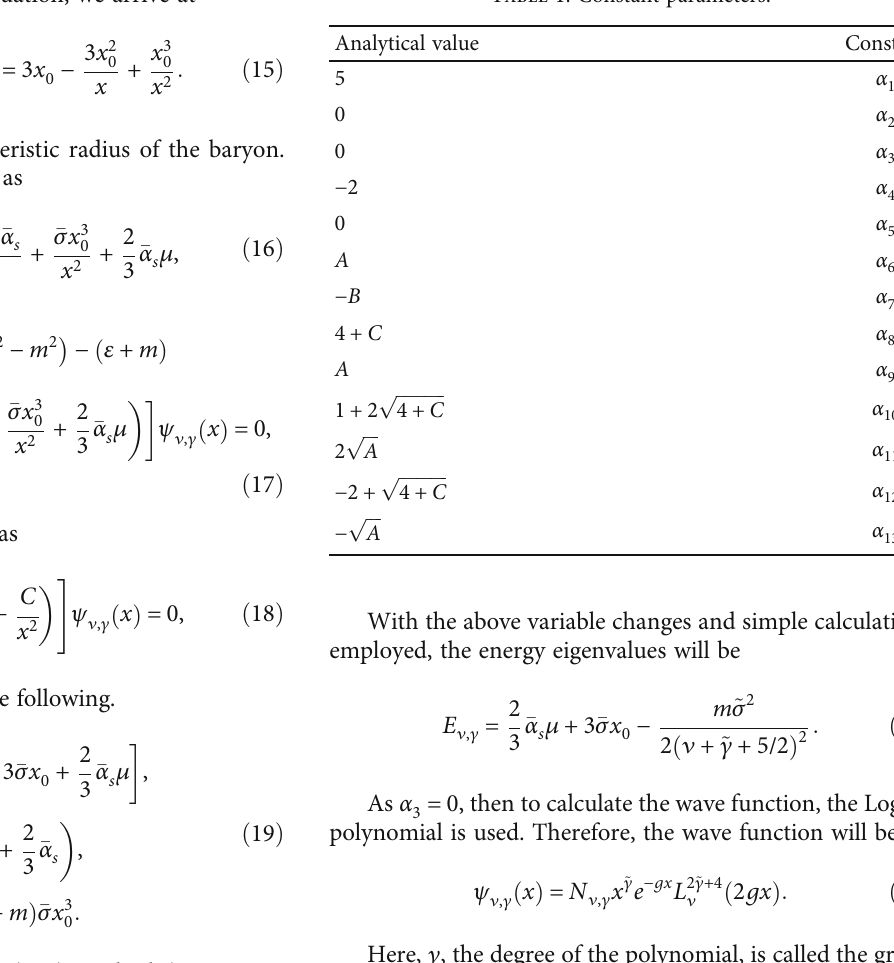
Table 1: Constant